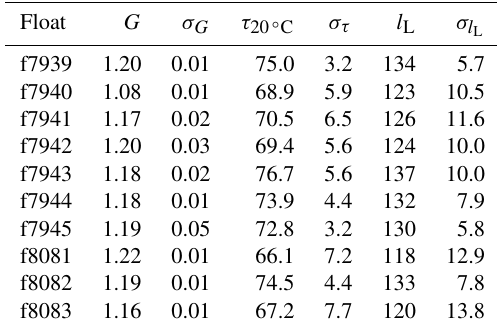
Table 2. Mean gain values derived from in-air measurements ( G , unitless), median time constants ( τ 20 ◦ C , s), and median boundary layer thickness values ( l L , µm) for each float with standard devia- tions ( σ , appropriate